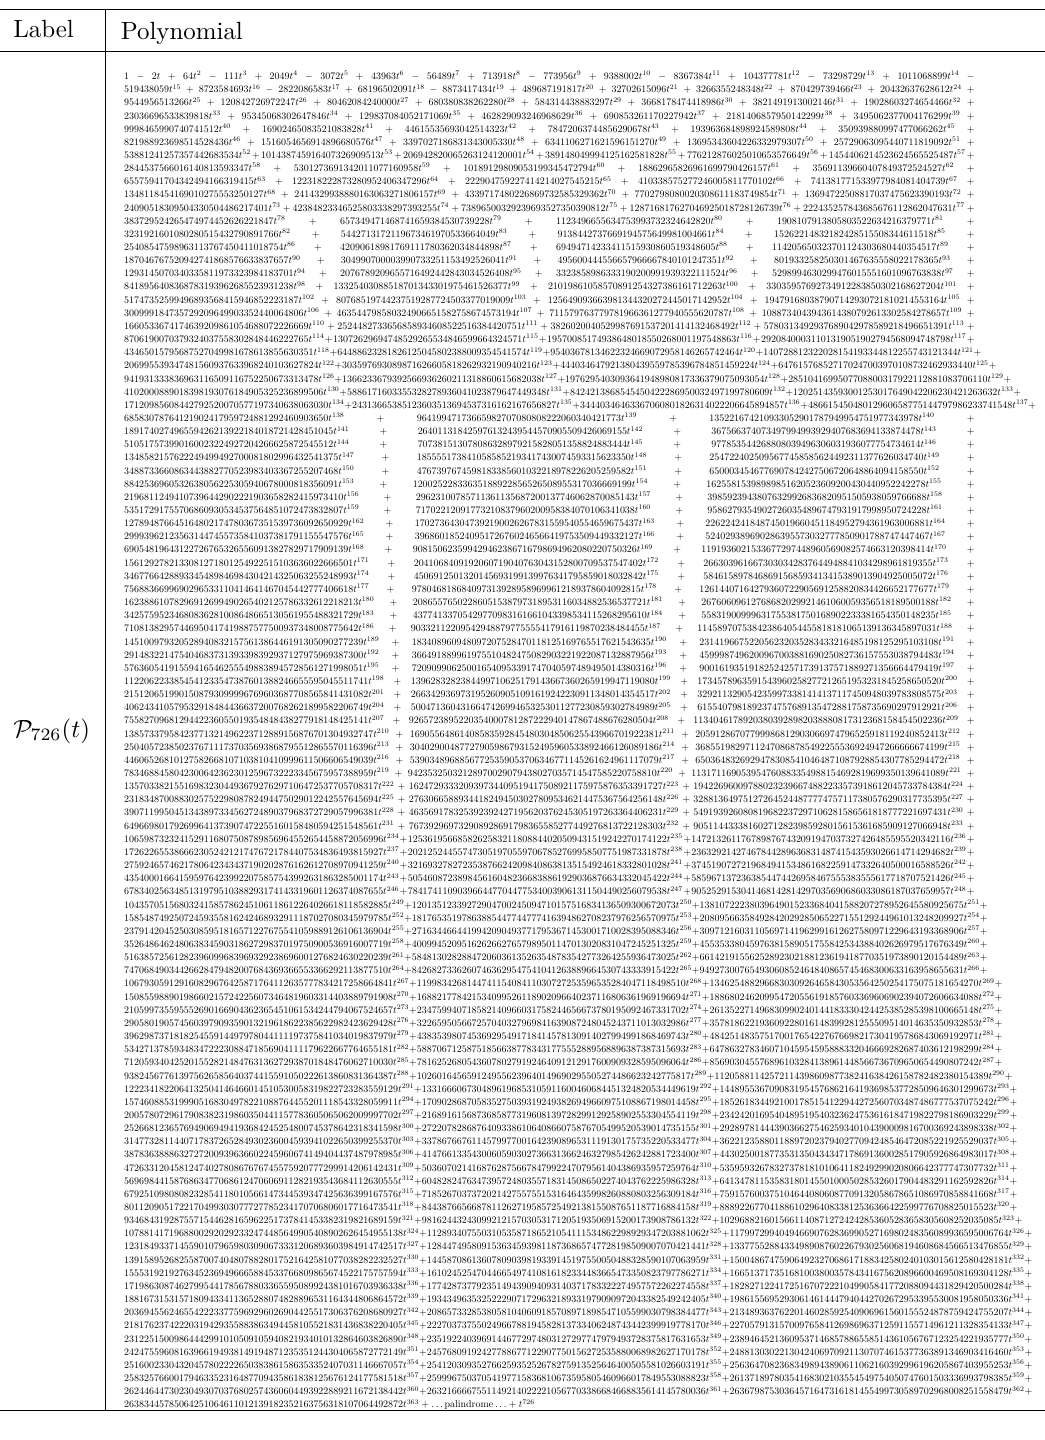
Table 44. Palindromic polynomials